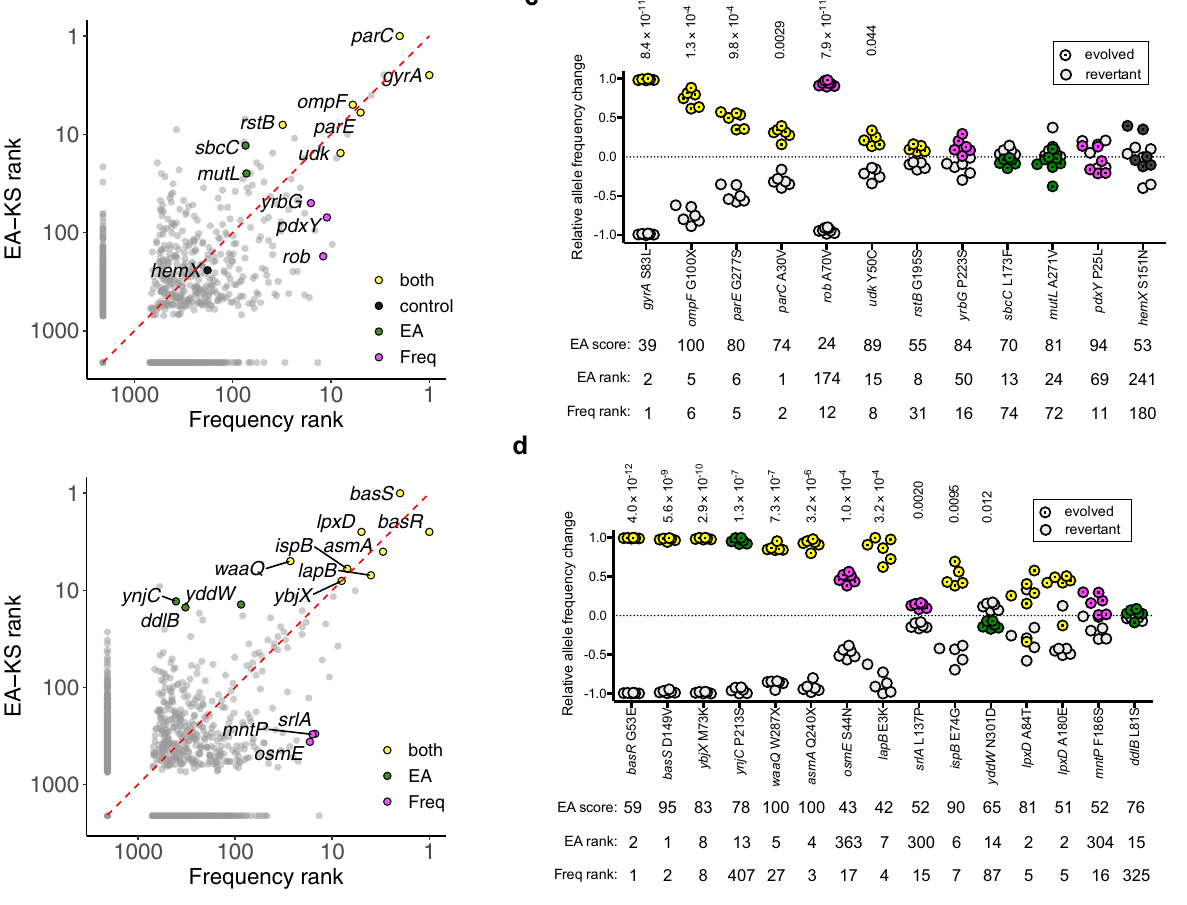
Fig. 3 Mutations in genes highly ranked by both EA integration (EA-KS approach) and frequency analysis contribute to fi tness. a , b The combined rankings for cipro fl oxacin and colistin datasets using both EA integration (EA-KS) and frequency-based analysis. Genes that were chosen for subsequent experiments are labeled with their names and colored yellow if ranked highly by both EA integrals and frequency analysis, green if EA speci fi c, and magenta if frequency speci fi c. The evolved strains and isogenic revertants of indicated mutations were competed in the presence of ( c ) cipro fl oxacin or ( d ) colistin. In the competition assays ( c , d ), n = 4 independent biological samples for hemX. N = 5 independent biological samples for udk , rstB , and ispB . N = 8 independent biological samples for rob and mutL . All other genes were repeated with n = 6 independent biological samples. Relative allele frequency change after the competition of the evolved allele and the wild type allele are plotted. EA scores (0-100, wherein 100 is highest predicted impact) for each tested mutation are indicated along with the overall rank of each gene based on either EA-KS aggregate ranks or frequency-based aggregate ranks. One sample two-tailed t-test ( µ 0 = 0) with Bonferroni correction was performed for each competition assay ( p values <0.05 reported above each dataset). Source data are provided as a Source Data fi